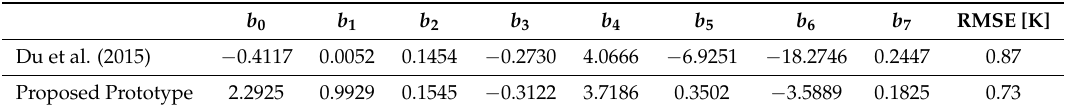
Table 1. Split window algorithm b-coefficients derived in this study compared the coefficients derived by Du et al. and the associated root mean square error of the model